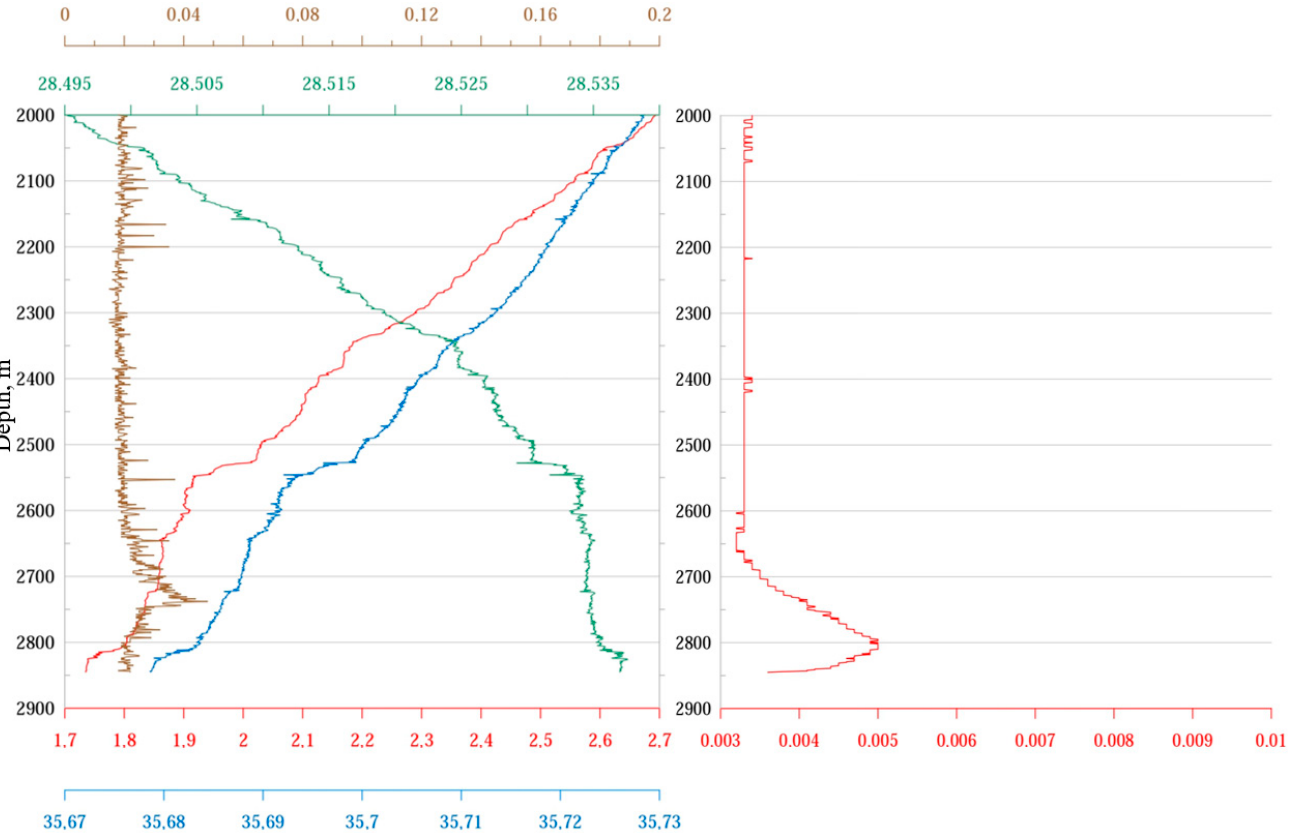
Figure 15. Results of CTD sounding at the Koralovoye field, station 41LP. Left: brown—turbidity, FTU; blue—salinity, ‰; red—temperature, °C; green—density, kg/m3; right graph: methane concentration, µmol/L. Table 4. Elevated (in italics), high (in bold), and abnormal (in italics and bold) concentrations of dissolved/solid